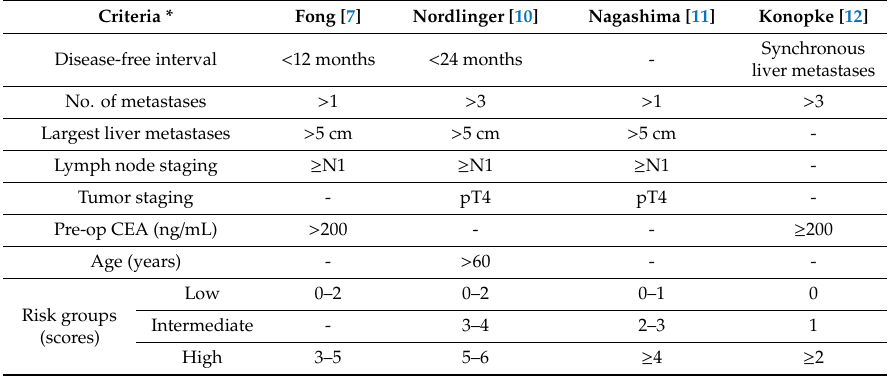
Table 1. Clinical risk criteria for assessing the risk of